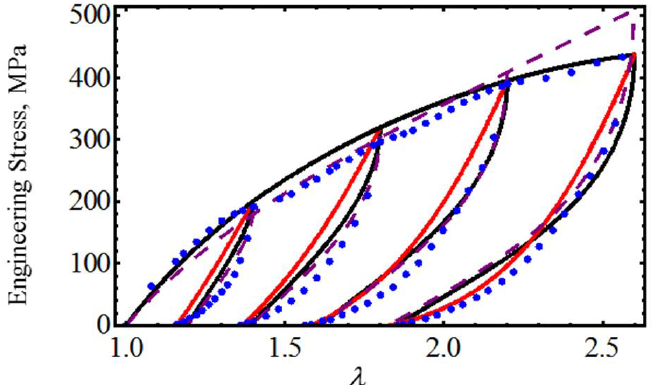
Figure 5. Engineering stress-stretch data for polypropylene sutures compared with theoretical predictions. The material parameter values used to obtain theoretical predictions from Equation (19) are summarized in Table 1, while the values of c = − 78 . 5996 J/m 3 ,